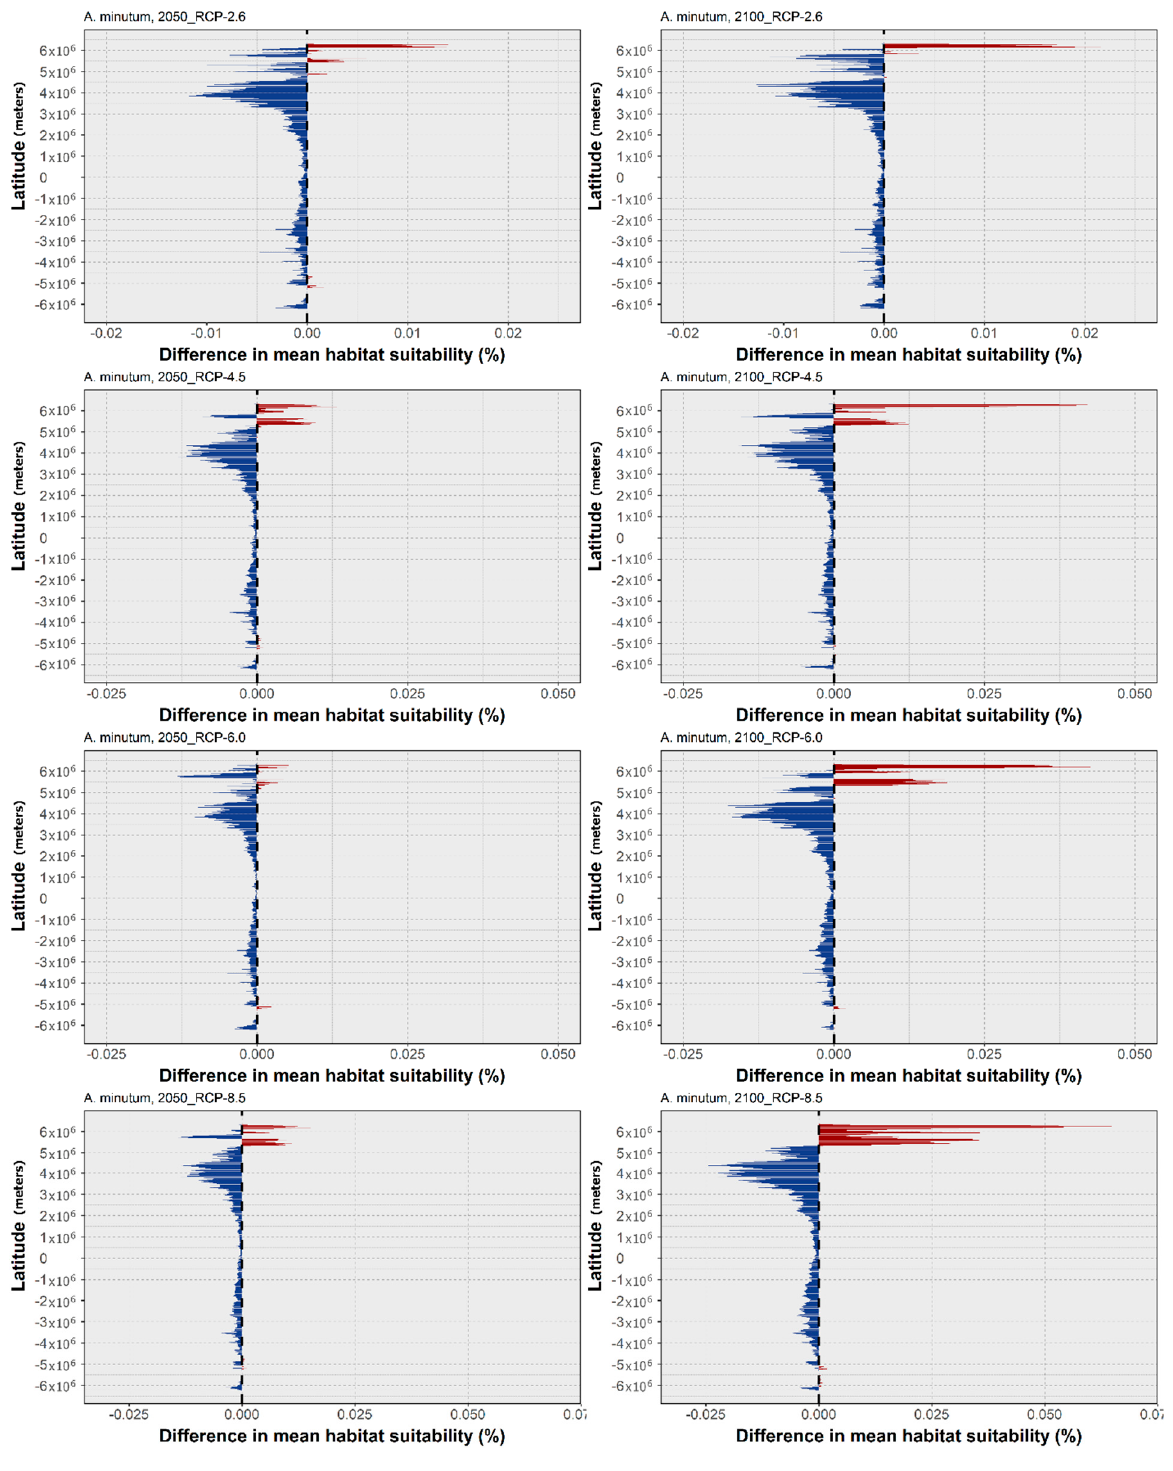
Figure 4. Projected changes in mean latitudinal habitat suitability for A. minutum between the present-day and 2050 ( left side ) and 2100 ( right side ), for each Representative Concentration Pathway scenario (RCP-2.6, 4.5, 6.0, 8.5; CMIP5), relative to the present-day baseline (i.e., the black dashed vertical line). Data to the right of the dashed line represents gains (red) and data to the left represents losses in mean habitat suitability (blue).